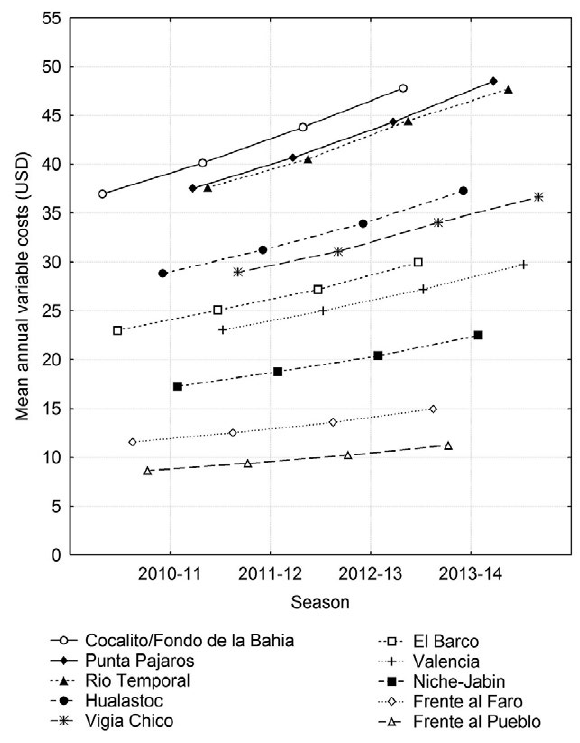
Fig. 8 – Mean variable costs in USD per trip by fishing areas and fishing